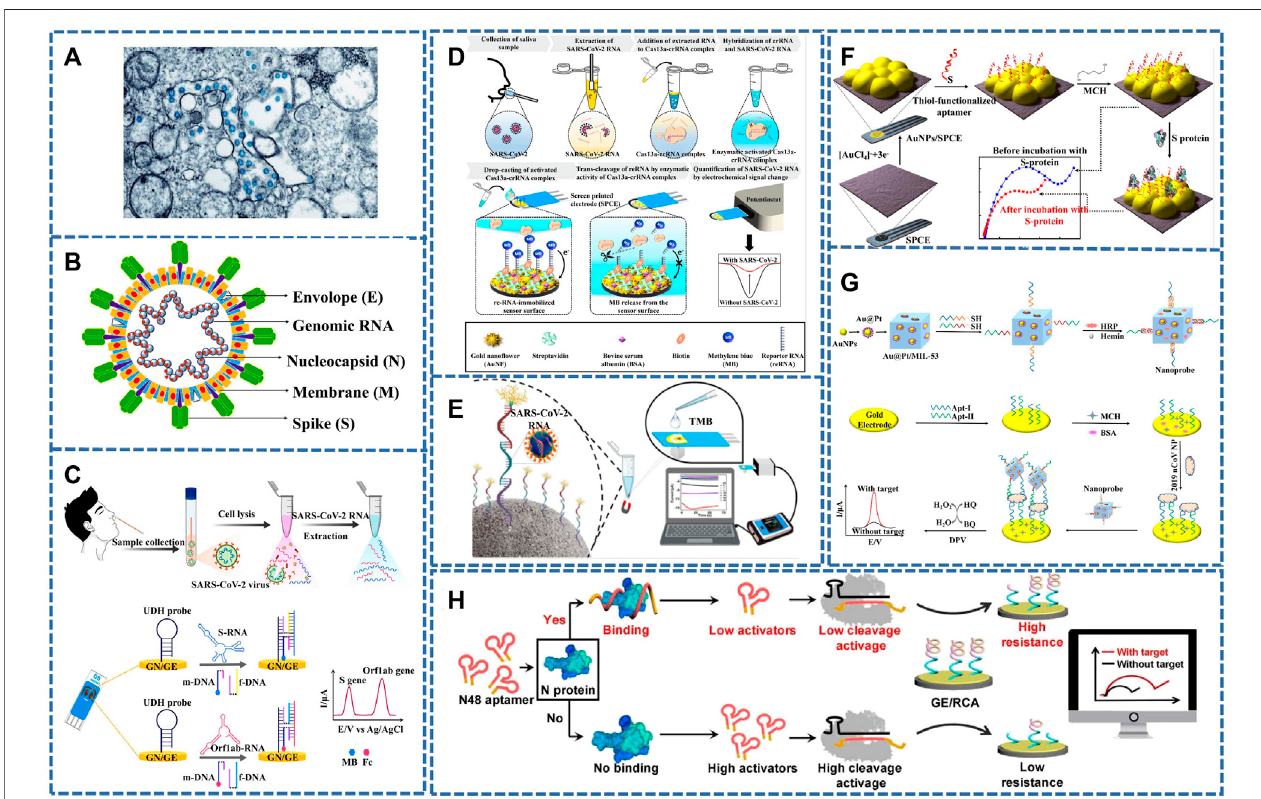
FIGURE 1 | (A) TEM image of SARS-CoV-2 (the blue globules) (Bullock and Tamin, 2020). (B) SARS-CoV-2 ’ s typical structure, S, M, E, and N proteins, encapsulates genomic RNA within virus particles (Kirtipal et al., 2020). (C) A detection work fl ow of SARS-CoV-2 RNA sequences from clinical samples using the electrochemical biosensor for detection of the S and Orf1ab genes (Kashe fi -Kheyrabadi et al., 2022). (D) Schematic diagram of an electrochemical biosensing strategy for SARS-CoV-2 detection using CRISPR/Cas13a. (Heo et al., 2022). (E) Schematic diagram of an electrochemical gene sensor for detecting SARS-COV-2 (Cajigas et al., 2022). (F) Diagram of the preparation steps of the sensor for detecting SARS-CoV-2 S protein. (Abrego-Martinez et al., 2022). (G) Schematic diagram of constructing electrochemical sensor based on Au@Pt/MIL-53 (Tian et al., 2021). (H) Strategy and work fl ow of SARS-COV-2 antigen detection by CRISPR-based electrochemical sensor (Liu et al.,